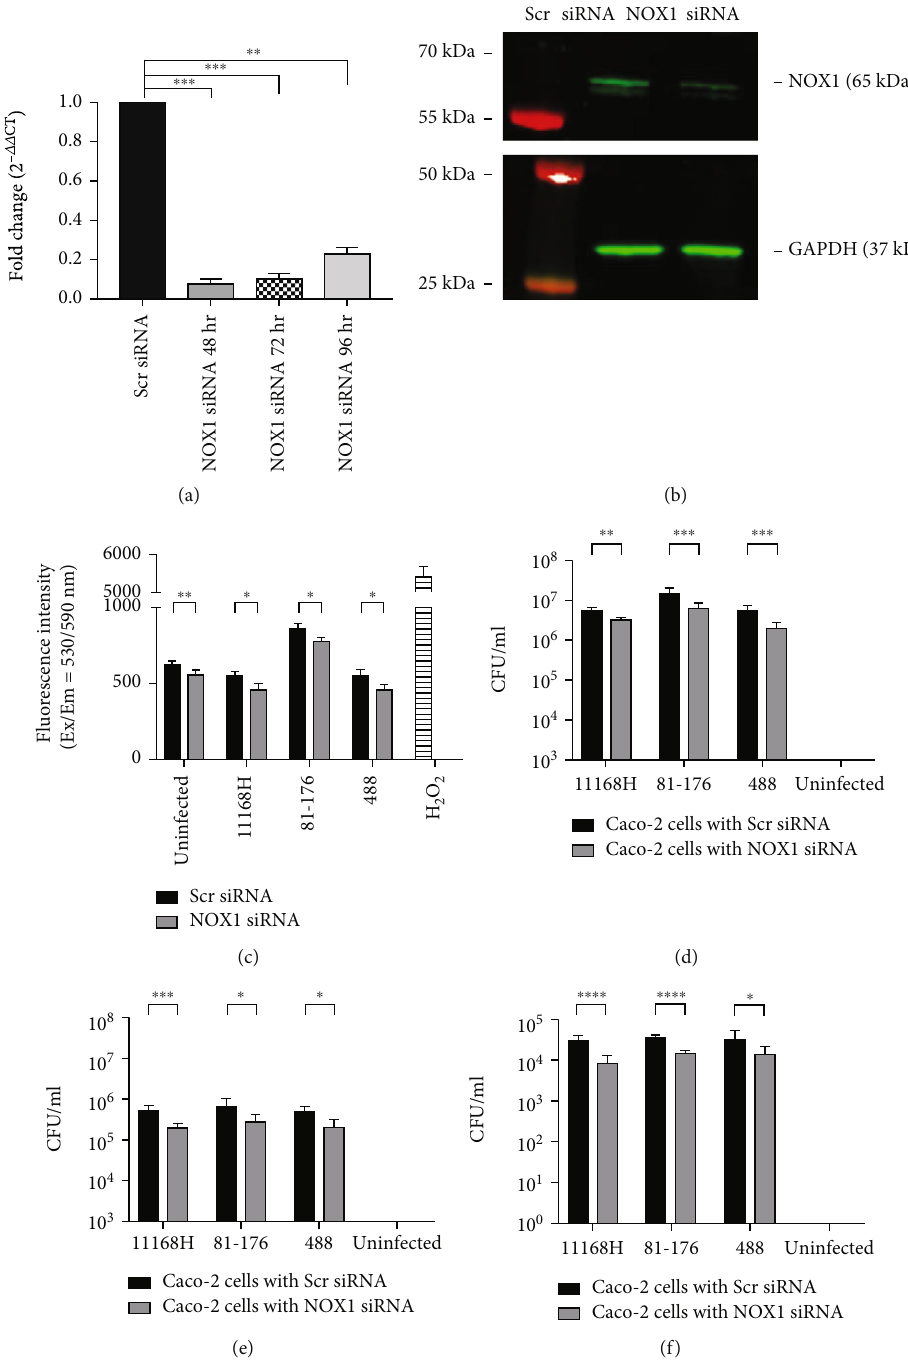
Figure 7: The e ff ect of NOX1 silencing on C. jejuni interaction, invasion, and intracellular survival. Caco-2 cells were transfected with NOX1 siRNA or scrambled siRNA (Scr siRNA). (a) qRT-PCR showing expression of NOX1 after siRNA transfection. (b) Western blotting showing expression of NOX1 after 72 hours of siRNA transfection. (c) Detection of extracellular ROS from Caco-2 cells after 72 hours of siRNA transfection followed by coincubation of C. jejuni for 3 hours. (d) After 72 hours of siRNA transfection followed by C. jejuni infection for 3 hours, Caco-2 cells were washed with PBS and lysed and the numbers of interacting bacteria were assessed or (e) for invasion assay, the cells were incubated with gentamicin (150 μ g/ml) for 2 hours to kill extracellular bacteria and then lysed, and the numbers of intracellular bacteria were assessed. (f) For intracellular survival assay, 2 hours of gentamicin treatment